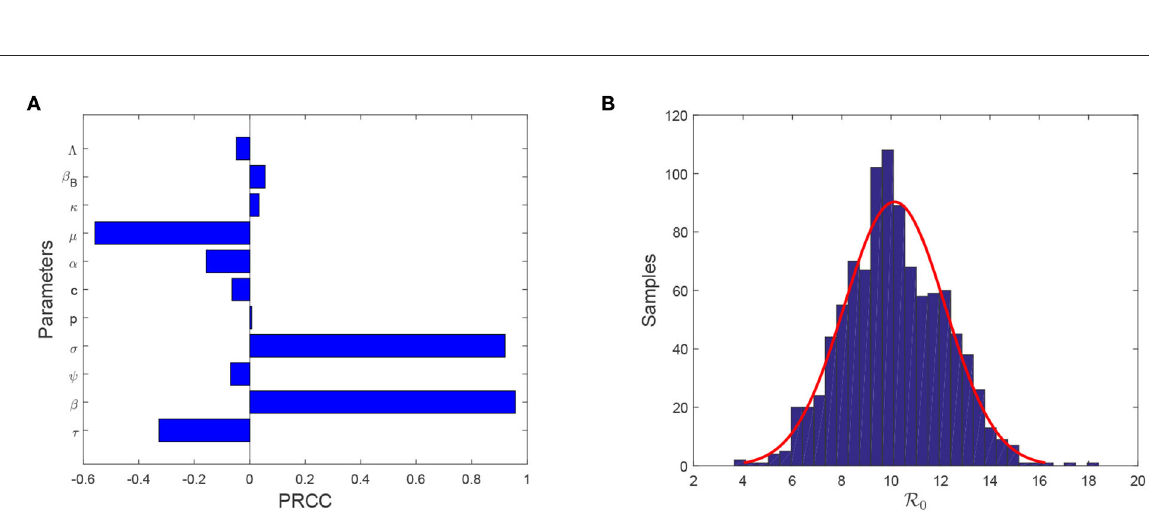
FIGURE3 (A) Tornado plot of PRCC for model parameters associated with R 0 . (B) Samples of R 0 .